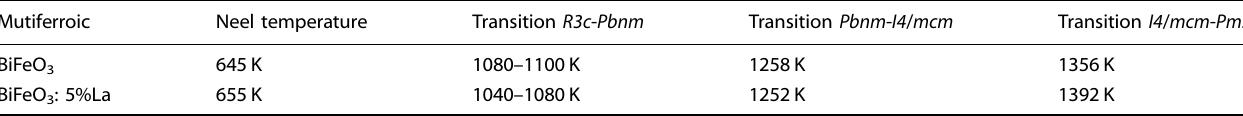
Table 1. Experimentally measured transition temperatures of BiFeO 3 and Bi 0.95 La 0.05 FeO 3 , collected from the refs. 9, 30, 54 as well as experimental data presented in this work Mutiferroic Neel temperature